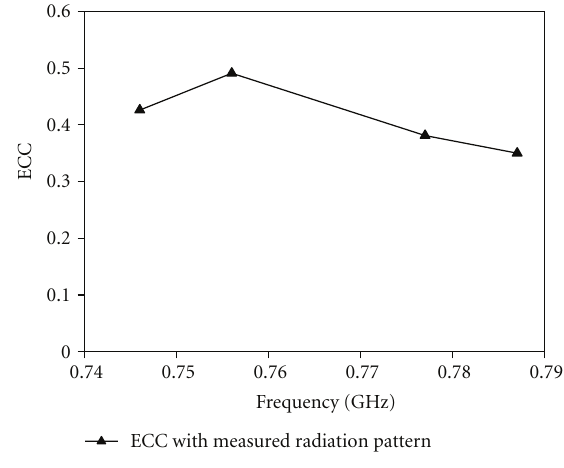
Figure 12: Measured ECC